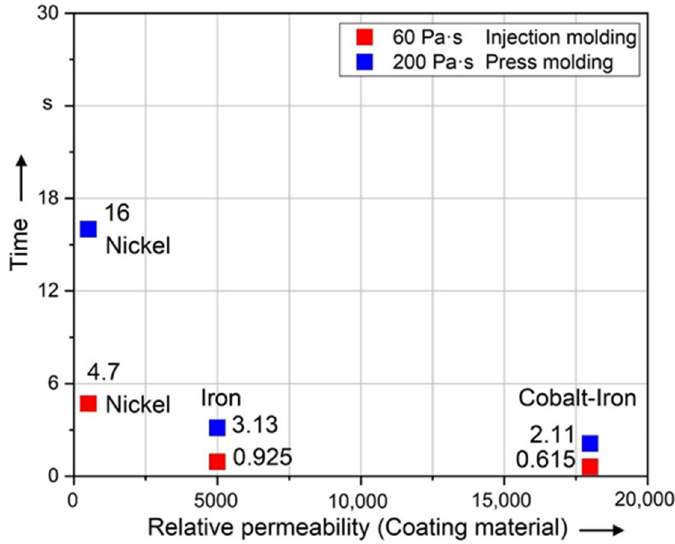
Figure 12. Time required to align long fibers (5000 µm) of different coating materials to 99% of 90°.